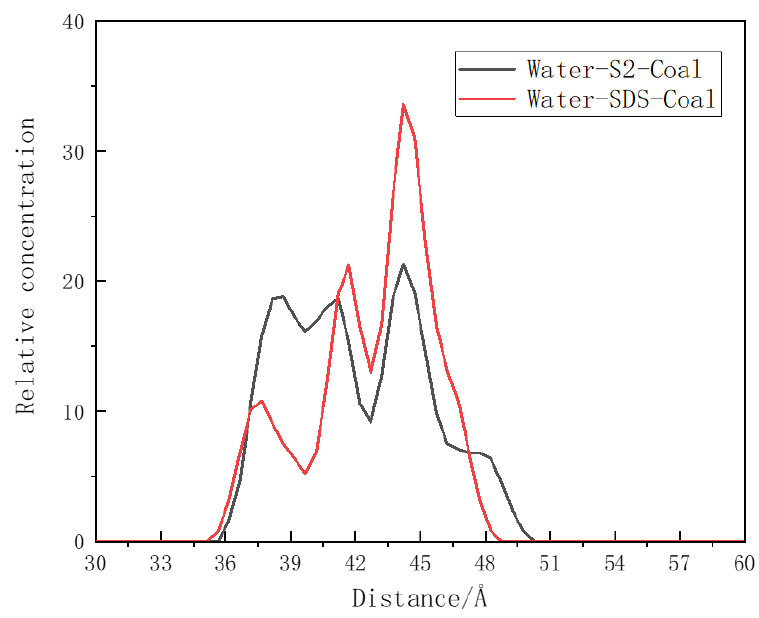
Figure 10. Relative concentration distribution of sulfur atoms along the Z axis. Table 4. Number of hydrogen bonds in water-surfactant-coal models and water-coal